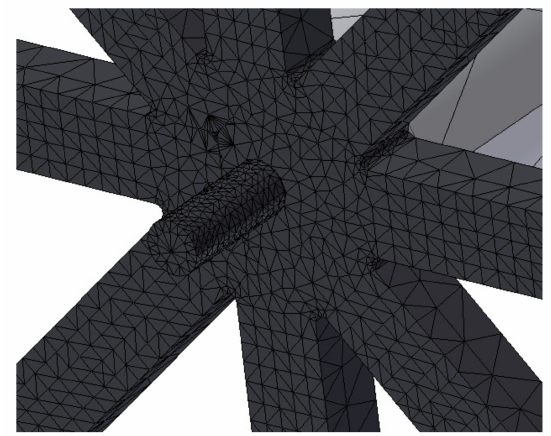
Figure 16. Refinement of the mesh at the ends of the shafts in contact with the